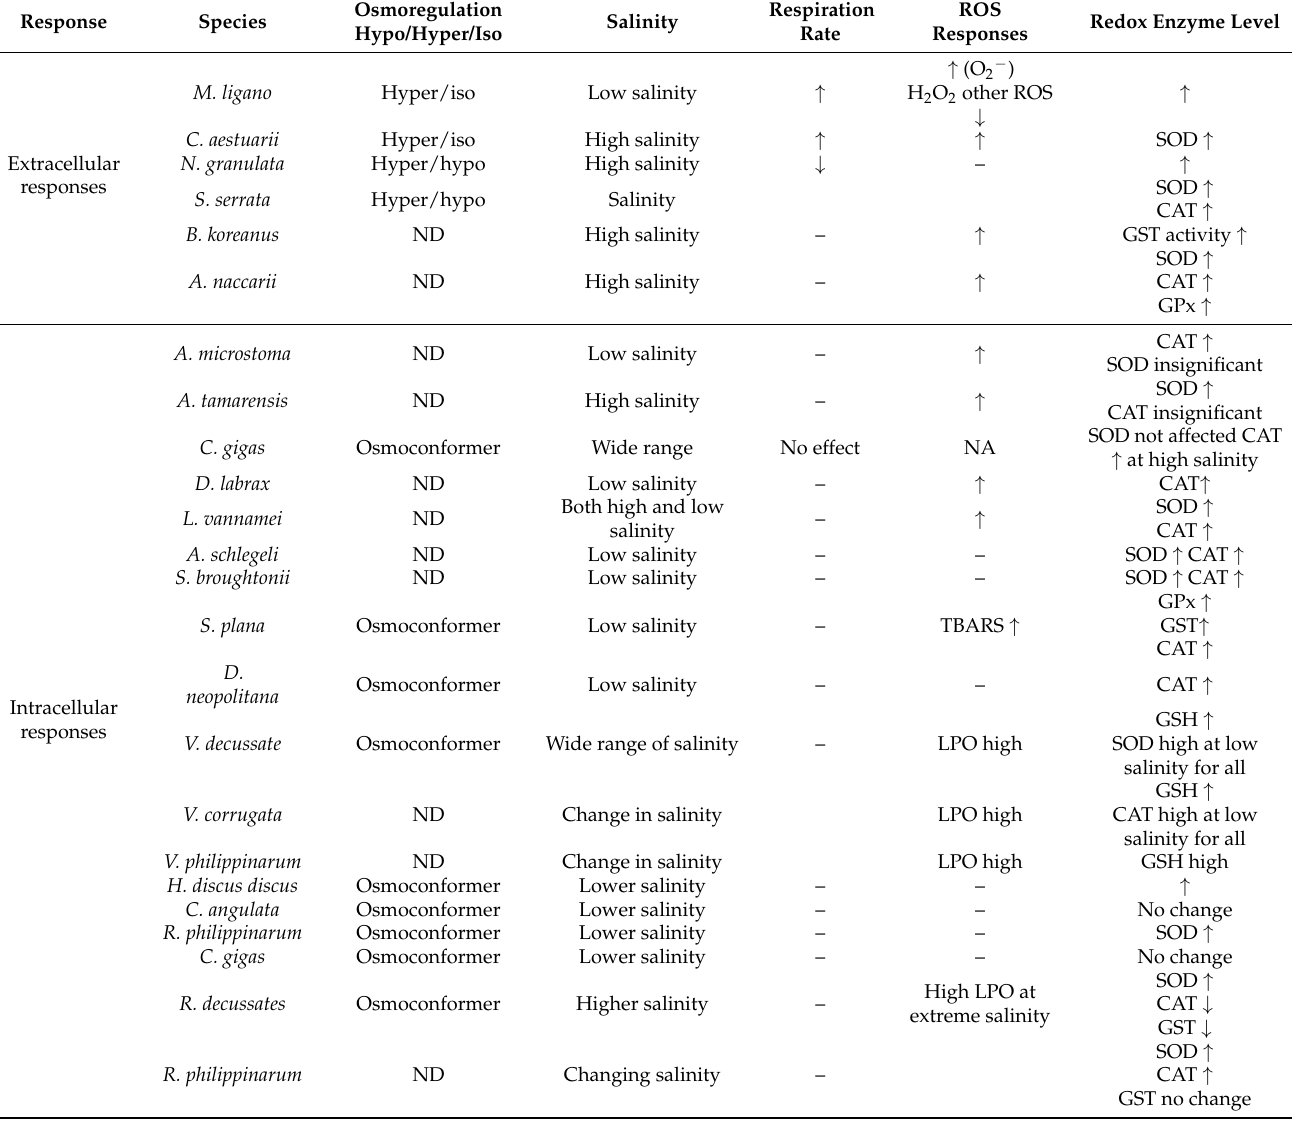
Table 3. Redox responses to counter OS in animals under salinity